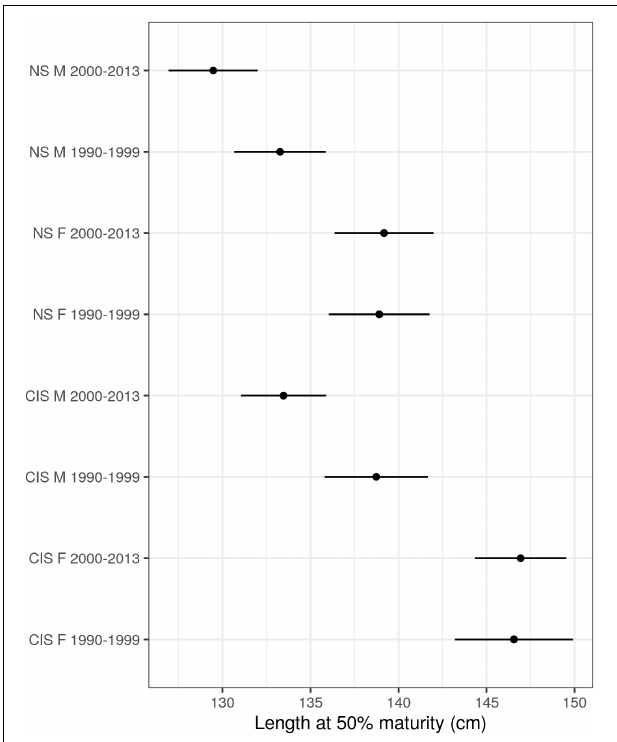
FIGURE 10 | Length at 50% maturity (cm) estimates from the best fitting maturity model for length (common length effect and separate intercepts by sex, time period, and management unit). Points represent the mean value with horizontal lines denoting the 95% confidence intervals.